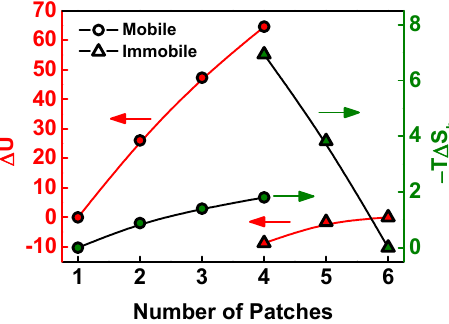
Figure 3. Variation of the enthalpy U and entropic loss − TS b of brushes as a function of the number of patches on a nanoparticle. For the mobile brushes, the ∆ U (and − T ∆ S b ) is the difference in enthalpy (and entropic loss) between the studied patchy patterns and the P 1 pattern, while for the immobile brushes, the ∆ U (and − T ∆ S b ) is the difference in enthalpy (and entropic loss) between the studied patchy patterns and the P 6 pattern. The parameters are R np = 1.8 R g and α = 0.4 R g − 2 . The density distributions were examined to understand the stretching of brushes on